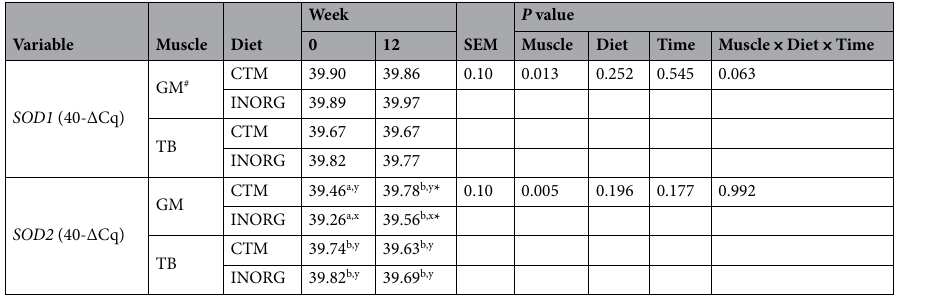
Table 3. Pre-trailer muscle Cu–Zn superoxide dismutase ( SOD1 ) and Mn superoxide dismutase ( SOD2 ) expression in the gluteus medius (GM) and triceps brachii (TB) at 0 and 12 weeks of submaximal exercise training in yearling horses supplemented with either complexed trace minerals (CTM; n = 8) or inorganic trace minerals (INORG; n = 8). # Within a variable, GM differs from TB ( P ≤ 0.05). *Within a row, mean differs from week 0 ( P ≤ 0.05). a,b Means with different letters differ ( P ≤ 0.05) due to muscle × time interaction ( P = 0.0004). x,y Means with different letters differ ( P ≤ 0.05) due to muscle × diet interaction ( P = 0.05).